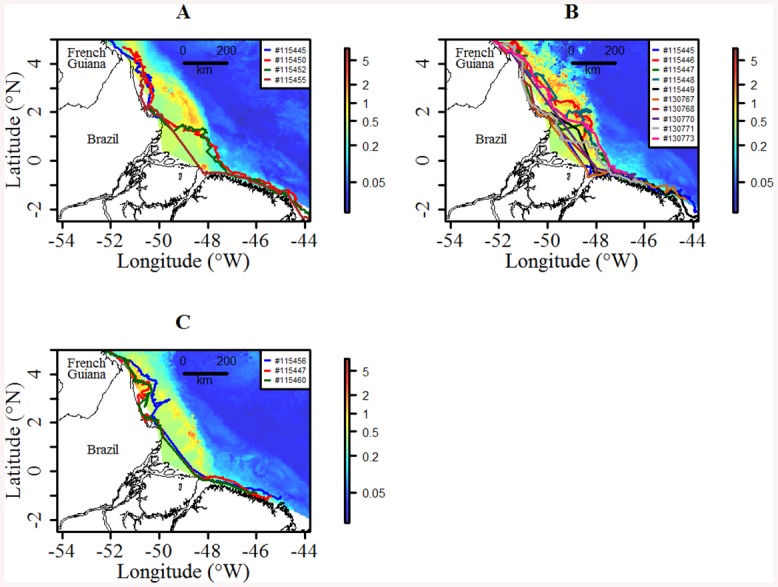
Map of Kd (m-1) within the plume for (A) May, (B) June and (C) July, with turtle routes superimposed for the corresponding months.The Kd was log transformed to improve representation and extracted monthly from Ocean Colour database and the shoreline comes from NOAA National Geophysical Data Center, Coastline.